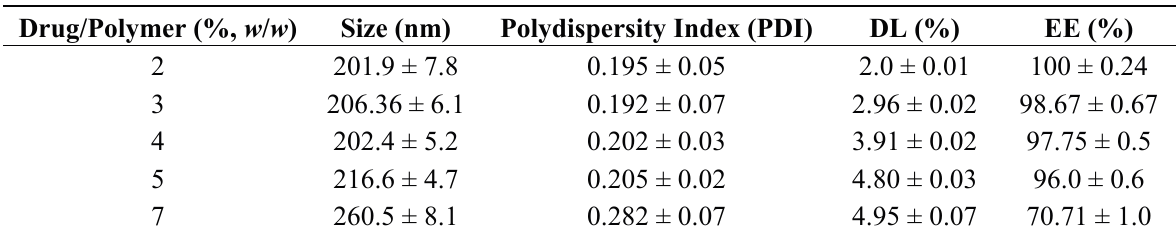
Table 1. Drug loading (DL) and encapsulation efficiency (EE) results of curcumin (Cur) –lipid-shell and polymer core nanoparticles (lpNPs) with Cur loading content between 2% and 7%.